Question: Provide a one-line summary of what is displayed.
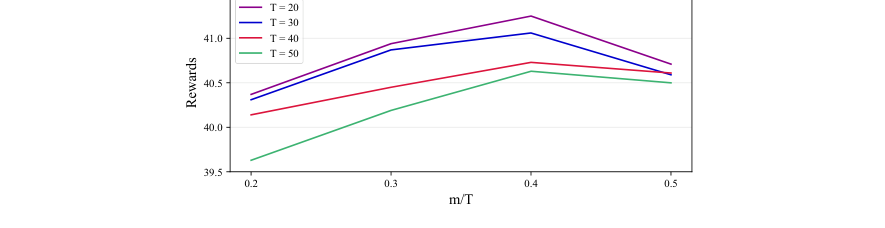
Answer: The impact of maximal early stop step m vs. various total sampling steps T.